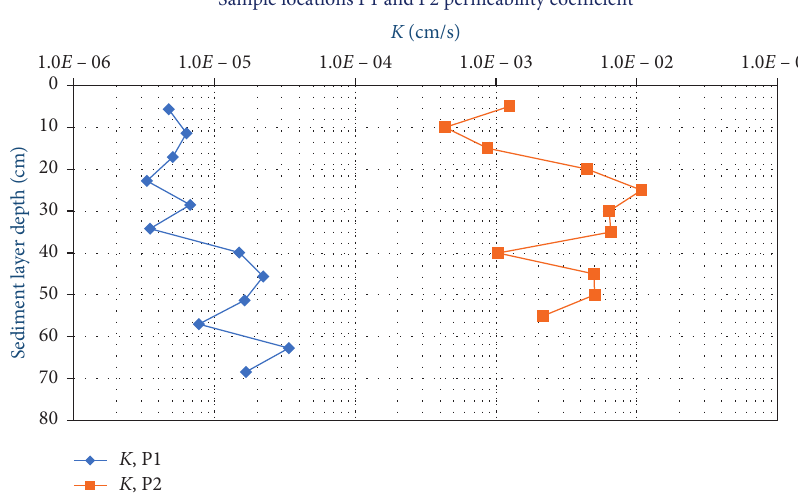
Figure 7: Hydraulic conductivity of sediment from locations P1 and